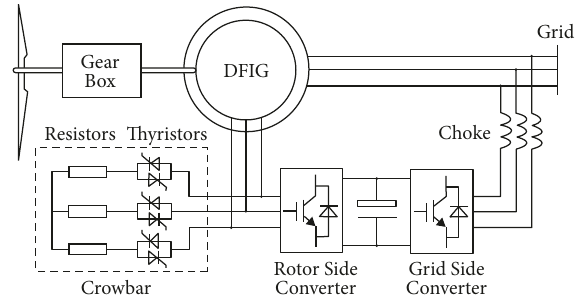
Figure 1: DFIG wind turbine